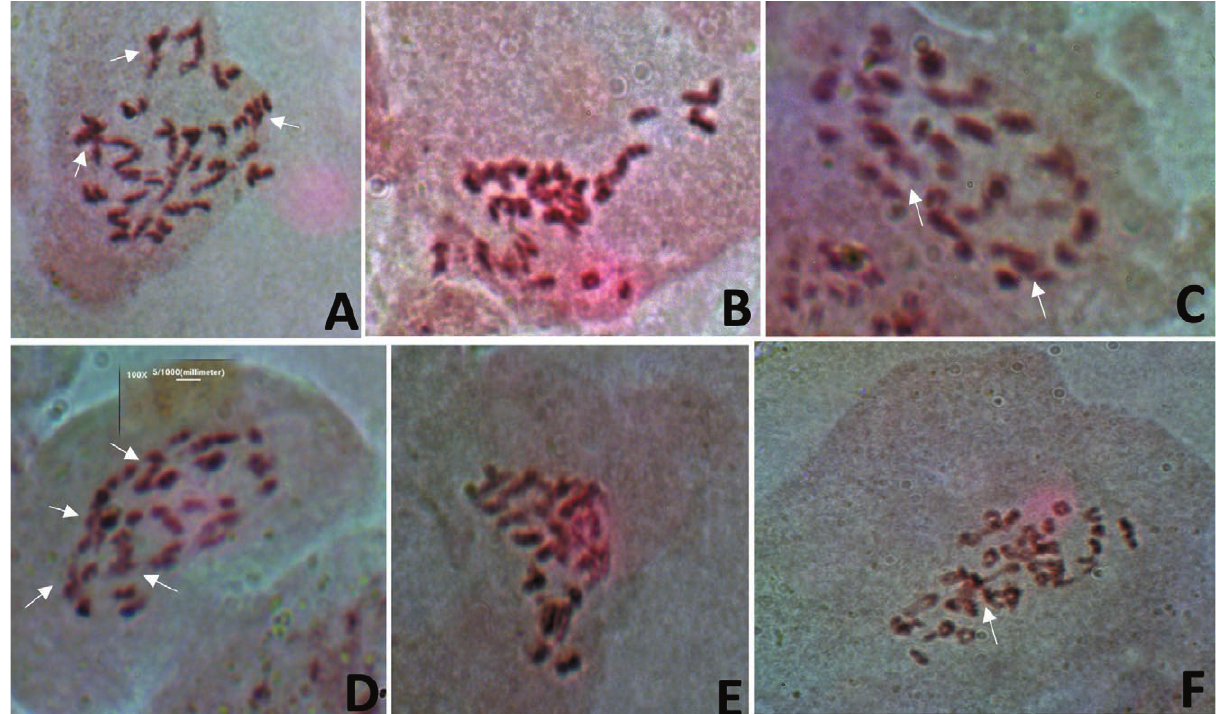
Figure 3. Mitotic metaphase spread in Dioscorea species studied. A. D. rotundata (Gaungaun), 2n = 38 (Arrows show chromosome over- laps); B. D. rotundata (Gaungaun), 2n = 38; C. D. rotundata (Sandpaper), 2n = 38 (Arrows show chromosome overlaps); D. D. rotundata (Ogunmole), 2n = 38 (Arrows show chromosome overlaps); E. D. rotundata (Areyingbakumo), 2n = 38; D. rotundata (Areyingbakumo), 2n = 38 (Arrow shows chromosome